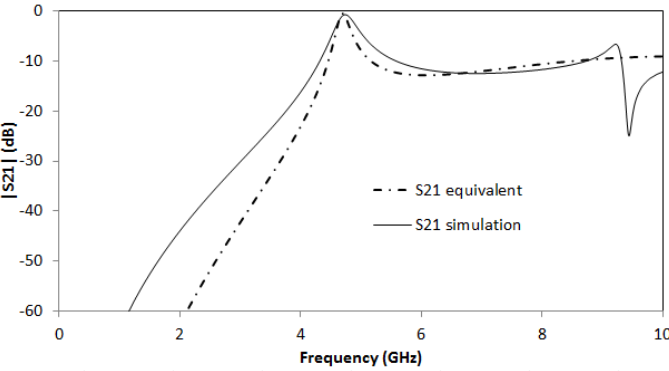
Figure 10. Simulated S21 (solid black line) and simulated S21 for equivalent circuit model (dash-dotted line).